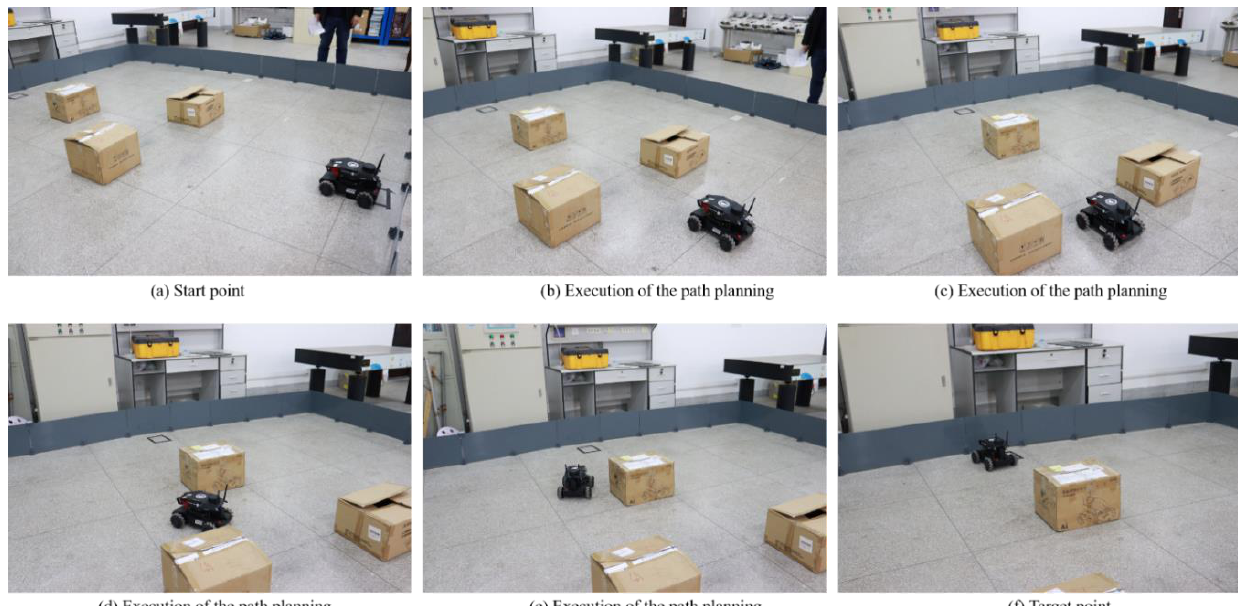
Figure 12. Experiment of the proposed APF-IRRT* algorithm in a real scenario.